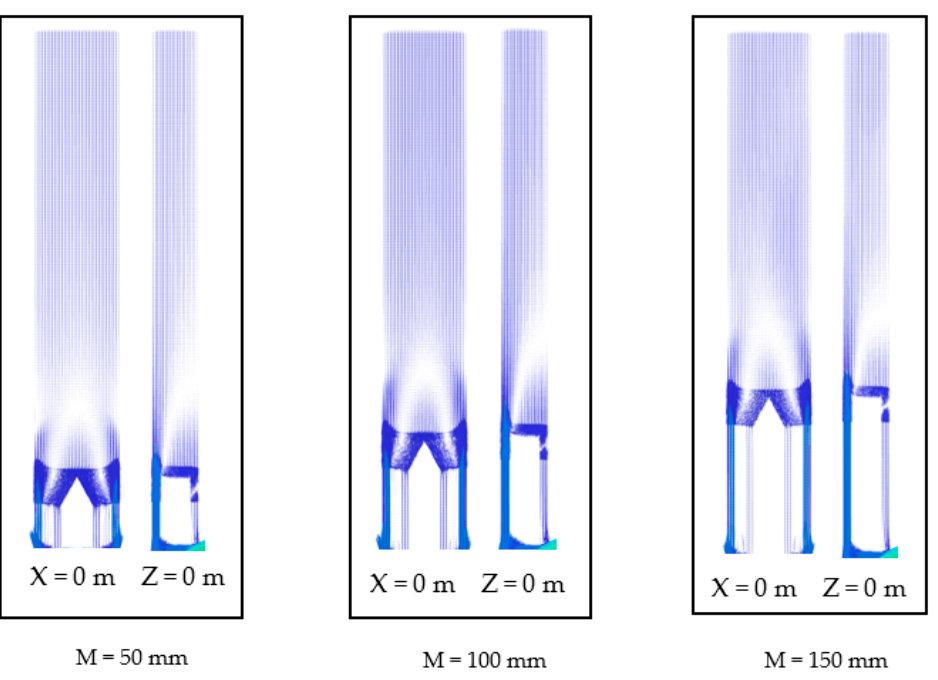
Figure 4. Streamline diagrams of different sections of the observation trough corresponding to different lengths of the TES.